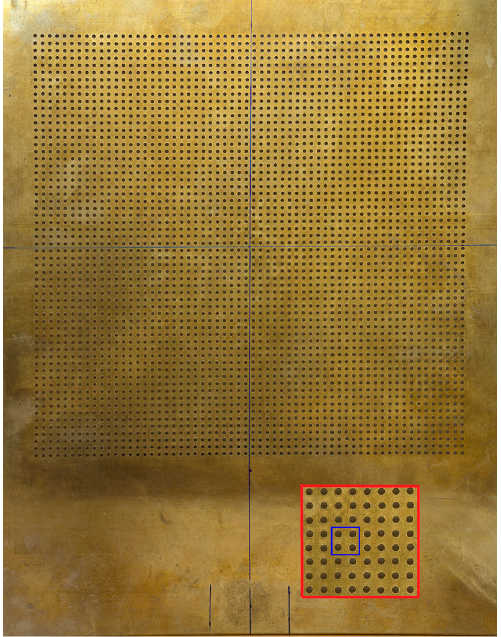
Figure 1. Structure and elementary cell for a brass plate perforated with periodically square distribution of circular holes.